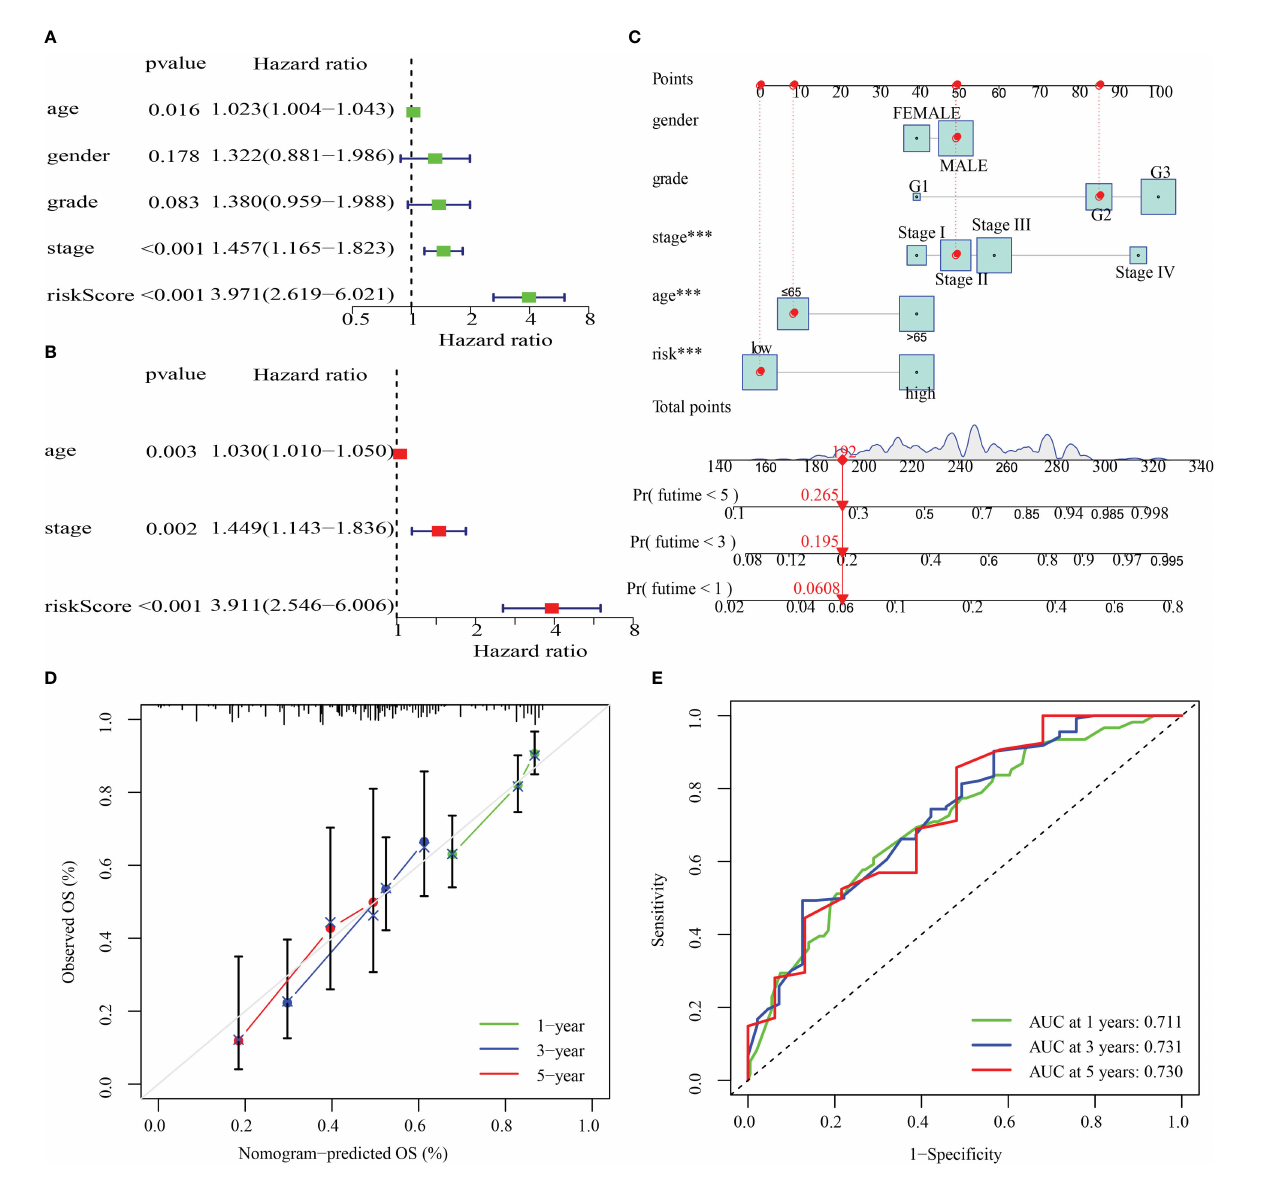
FIGURE 10 The development and validation of a risk score-based nomogram. (A, B) . Cox regression analysis, both univariate and multivariate, were performed on the training cohort. (D) Calibration curves for validating the nomogram ’ s capacity to predict outcomes over 1, 3, and 5 years. (E) The ROC curves ’ AUC values offer a better assessment of the nomogram ’ s prognostic capacity. ***P <